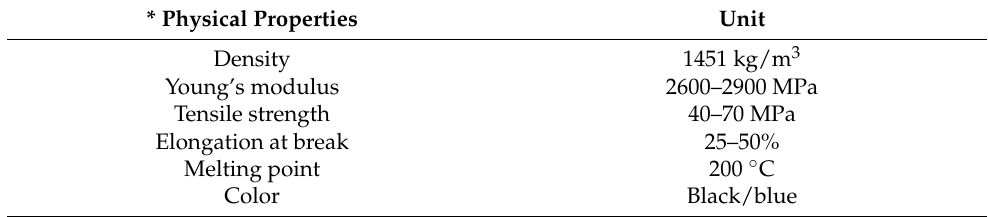
Figure 1. ( a ) Particle size analysis and ( b ) micrograph of crump rubber. Table 1. Crump rubber properties.